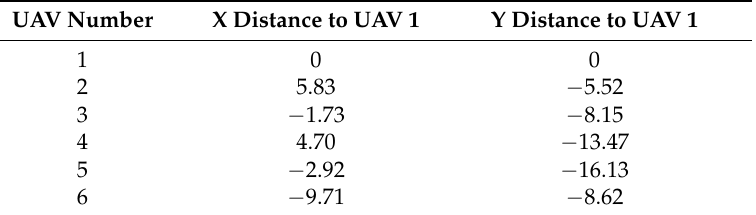
Table 4. Optimization results of indicator 4.